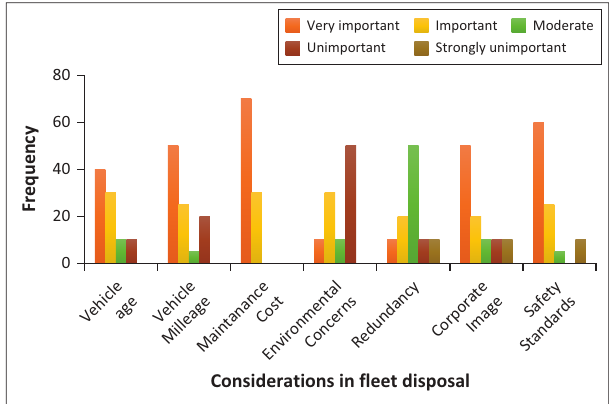
FIGURE 8: Key considerations in fleet